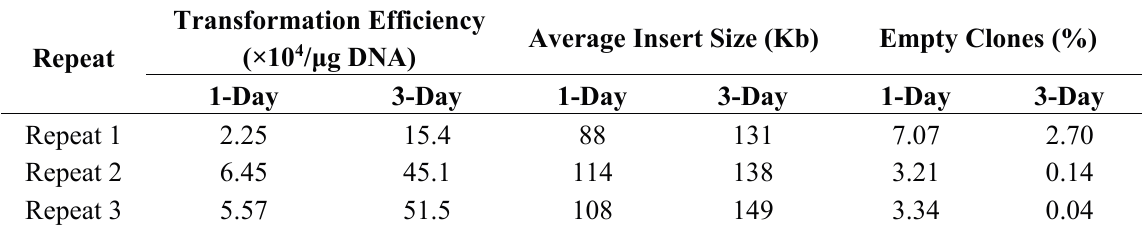
Table 1. Comparison between 1- and 3-day ligation